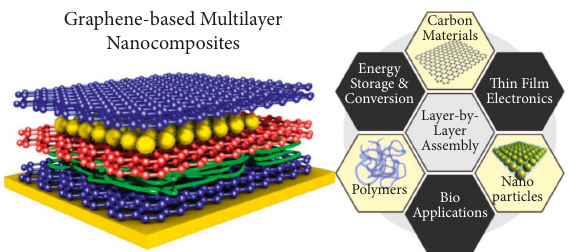
Figure 9: Carbonaceous nanomaterials with polymers using layer- by-layer method in energy harvesting applications